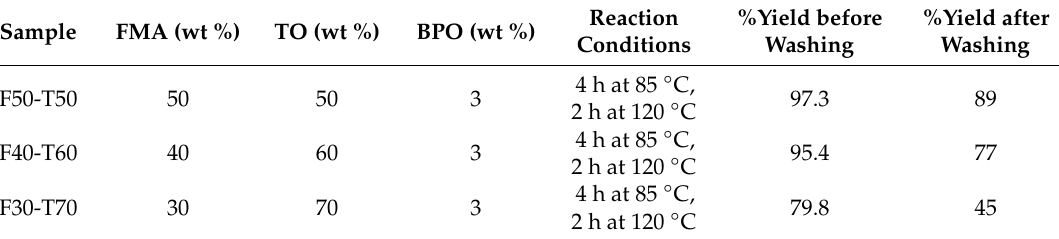
Figure 2. ( a ) As-synthesized samples after the free radical polymerisation, and the ( b ) same samples after washing with toluene. Table 1. Description of sample preparation and product yields.